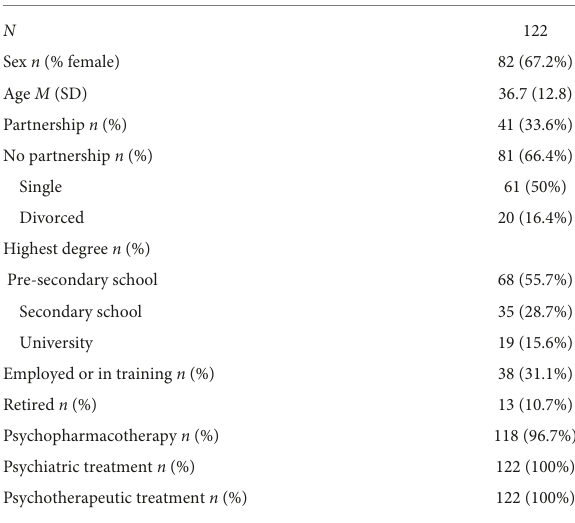
TABLE 1 Sociodemographic data of the study sample.